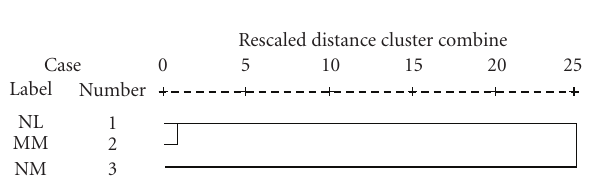
Figure 2: The dendrogram showing the cluster analysis of soil physical/chemical properties at 3 sites.